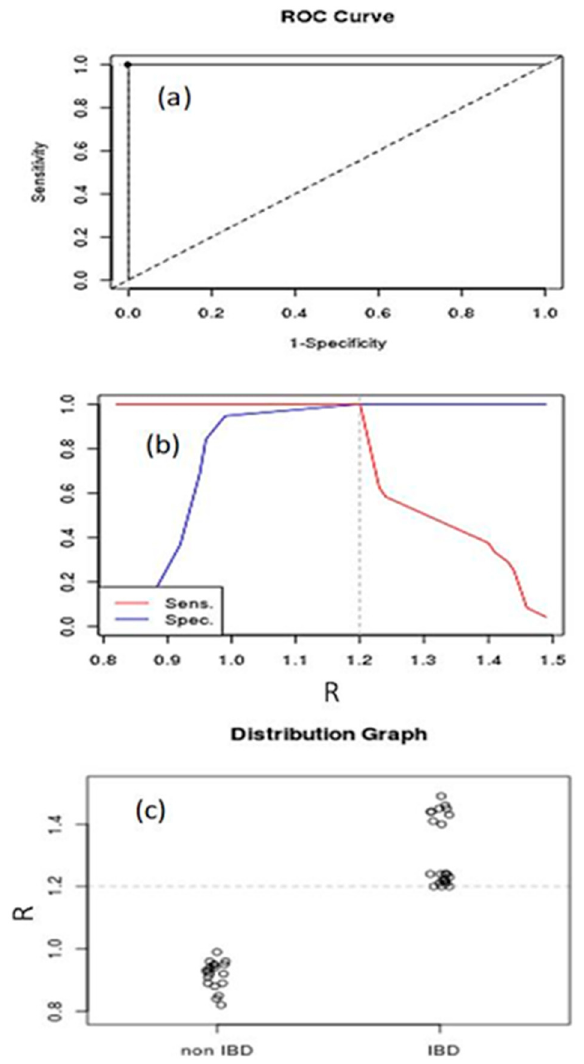
Figure 5. Receiver operating characteristic (ROC) curve ( a ), Youden index and optimal cutoff-point ( b ), and distribution graph ( c ) for IBD and non-IBD subjects.